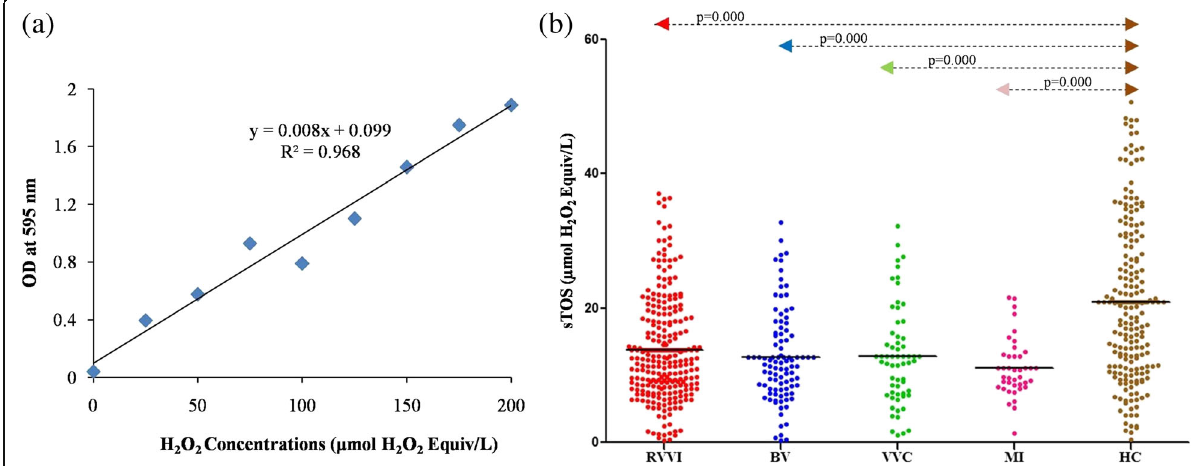
Fig. 2 a Standard curve for quantitative evaluation of sTOS. b sTOS in different clinical categories of RVVI and healthy controls (HC). Dot plot presenting the distribution of sTOS in patients and controls. Horizontal line signifies the mean